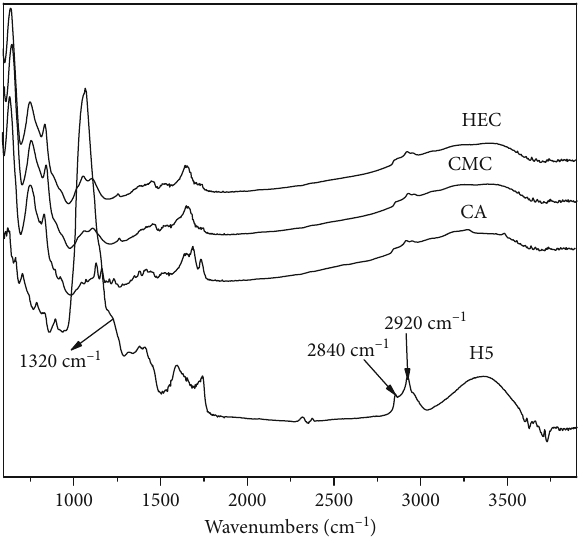
Figure 8: FTIR spectra for the CMCNa and HEC polymers, CA, and the hydrogel (H5) prepared from CMCNa and HEC (3% wt) (at the weight ratio of 3:1 with 5% concentration of